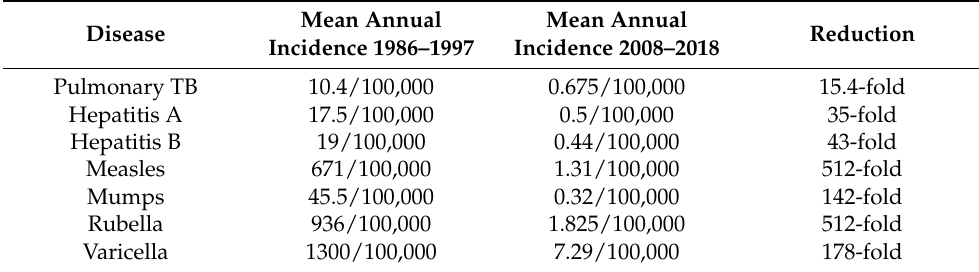
Table 5. Mean annual incidence of some vaccine-preventable infectious diseases in the Italian military in two different periods as well as relative